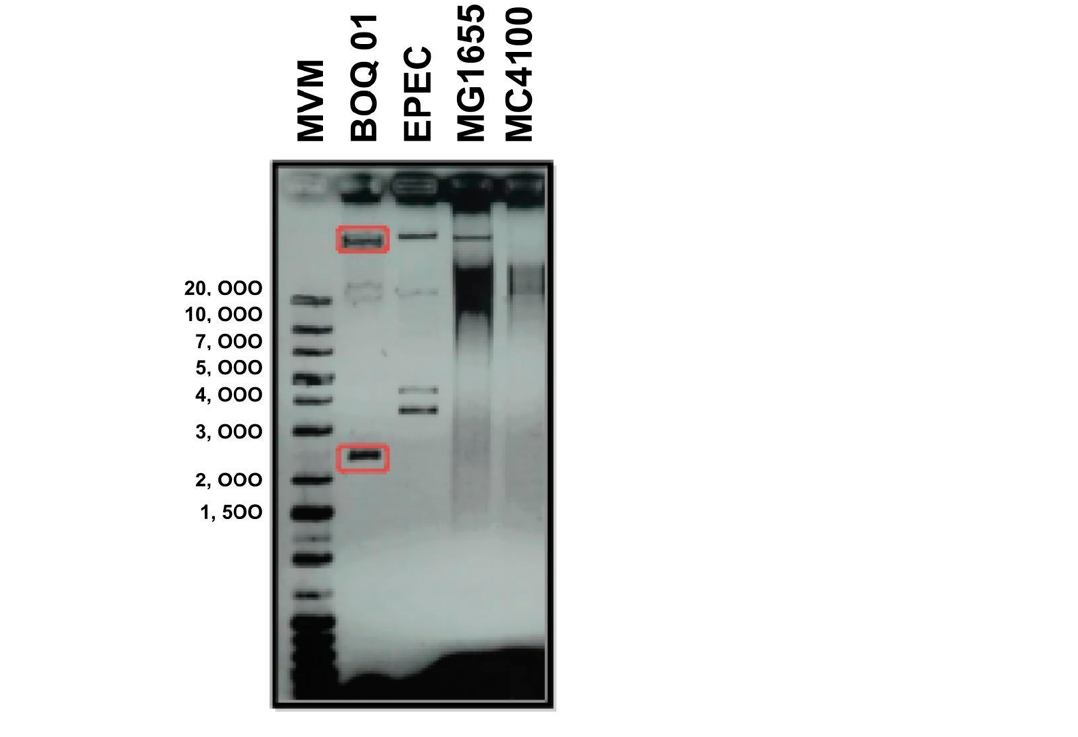
Figure 1. Eckhardt-type gel showing the plasmid patterns of E. coli BOq 01 strain and other E. coli strains. Lanes: (1) molecular weight markers (MWM), (2) E. coli BOq 01 strain, (3) enteropathogenic E. coli (EPEC), (4) E. coli MG1665 strain, and (5) E. coli K-12 MC4100.